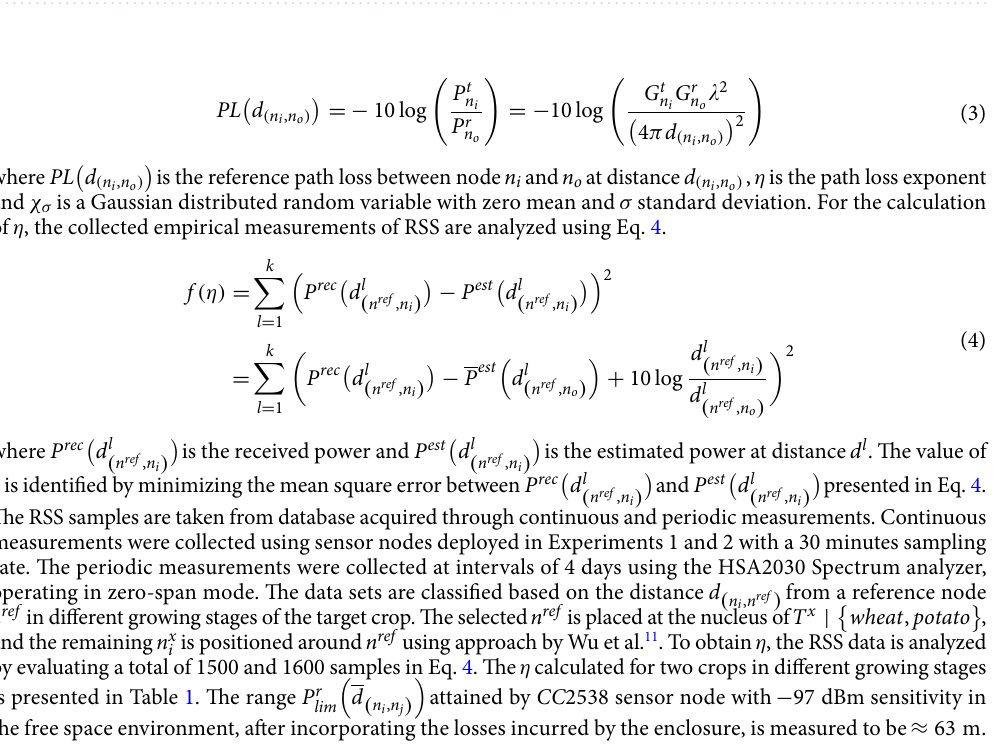
Table 1. The calculated η for two crops in different growing